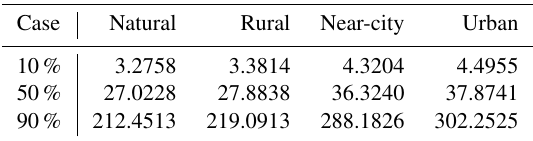
Table C1. Total mass concentrations of the semi-volatile organic compounds used in the four different environmental conditions. Val- ues are in µgm − 3